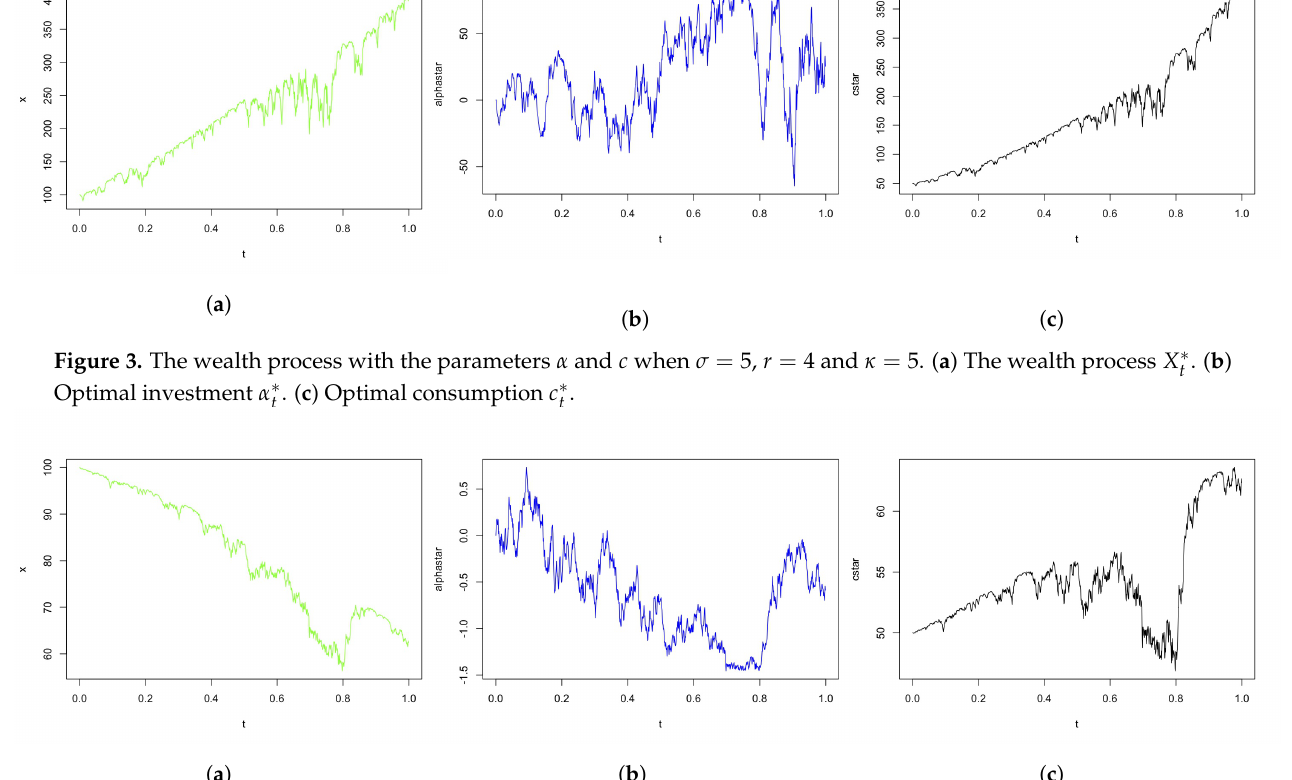
Figure 4. The wealth process with the parameters α and c when σ = 20, r = 0.01 and κ = 0.5 with n = 1000. ( a ) Wealth process X ∗ . ( b ) Optimal investment α ∗ . ( c ) Optimal consumption c ∗ t t